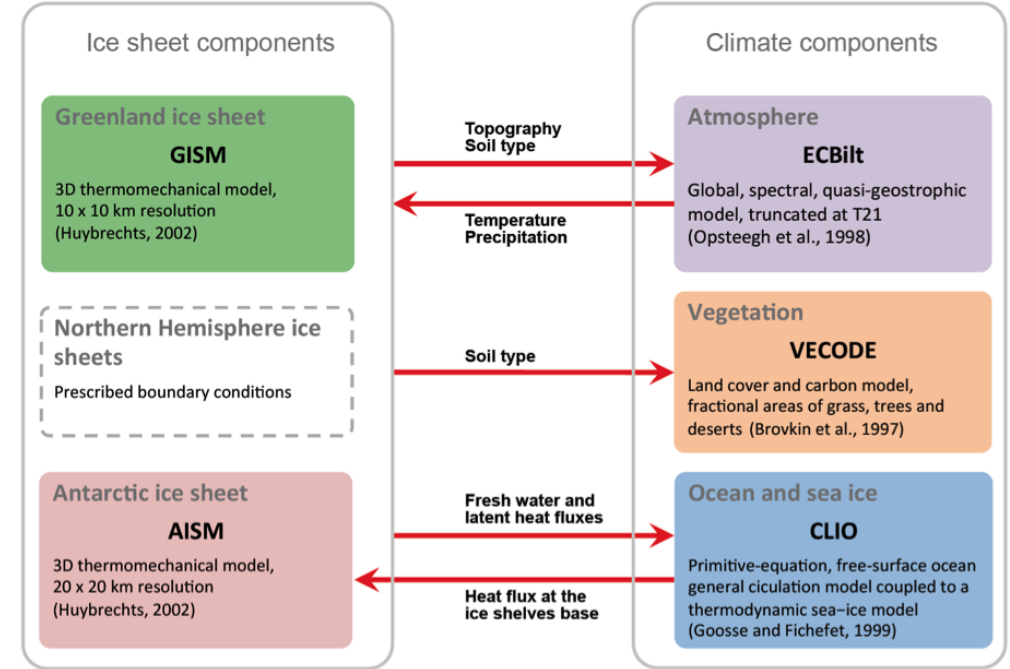
Figure 1. LOVECLIM model setup for the present study including dynamic components for the Greenland and Antarctic ice sheets and prescribed Northern Hemisphere ice sheet boundary